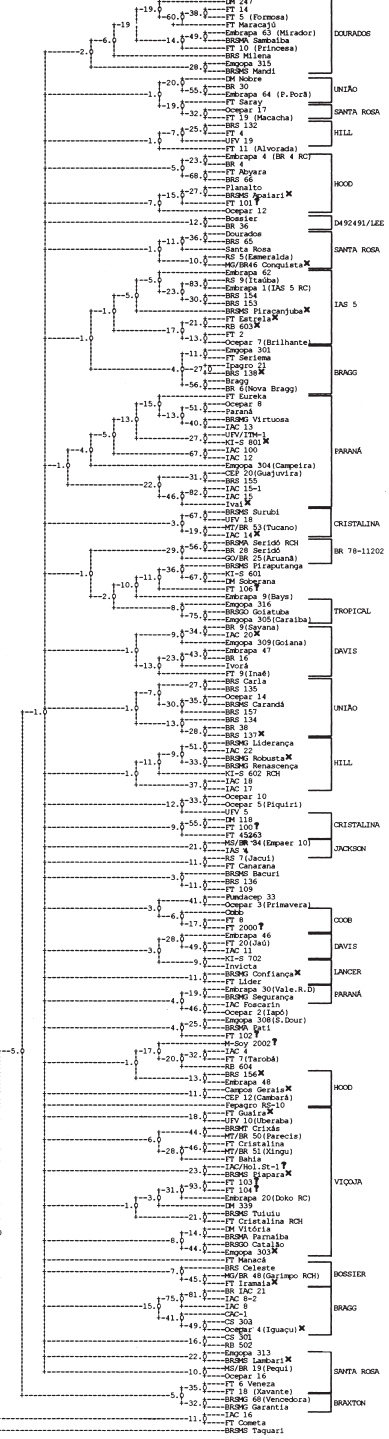
Figure 2 - UPGMA consensus dendrogram relating 186 soybean cultivars. Genetic distances were based on information for 12 microsatellite loci and calculated for each pair-wise comparison according to Diwan and Cregan (1997). The brackets on the right indicate the common parent identified in a cluster. x marks refer to cultivars present in a cluster, not corresponding to theircommonparent.Questionmarksindicatecultivarswithnoinformation on their pedigree. All bootstrap values out of 100 replicates are shown at the corresponding